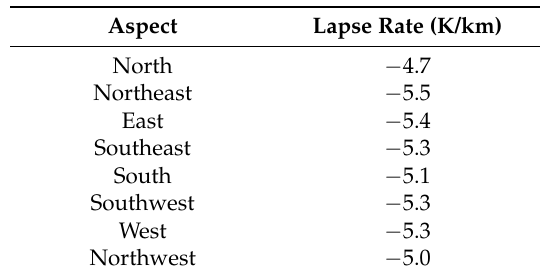
Table 3. Temperature lapse rate at different terrain aspects derived from the remote sensing based daily